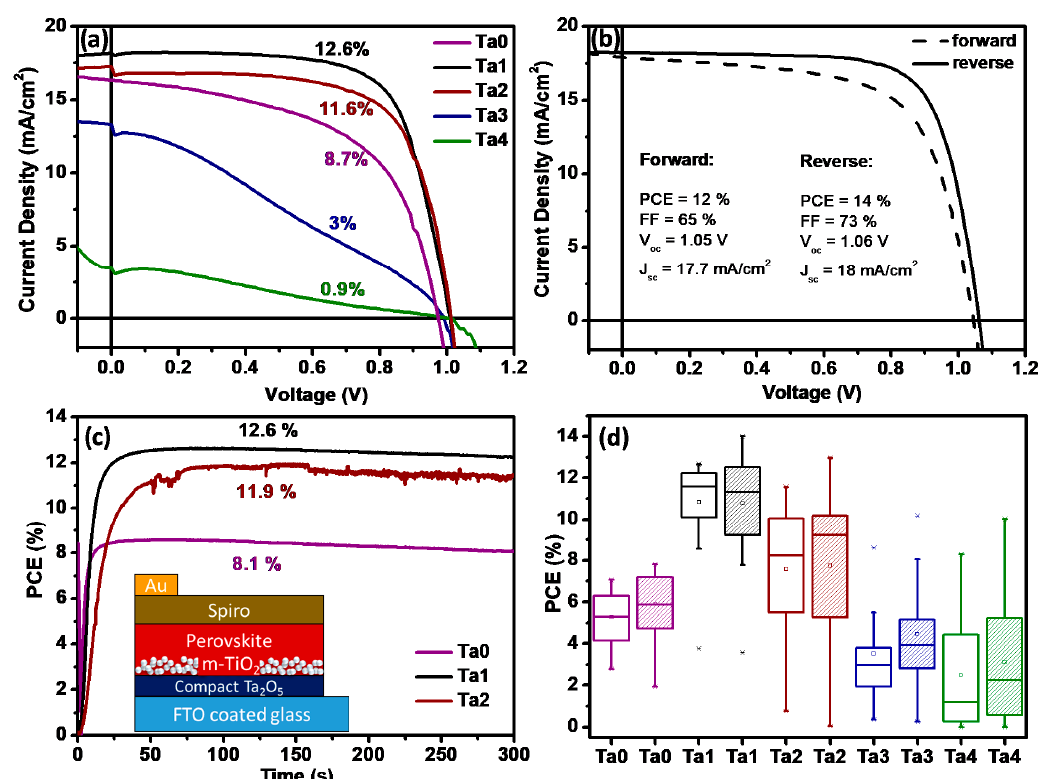
Figure 5. Comparison of ( a ) J–V curves (forward sweep). ( b ) Champion cell of perovskite solar cells employing Ta 2 O 5 as ETL (Ta1). ( c ) Steady-state power conversion efficiency at maximum power point (0.78 V applied bias); inset shows a schematic of the layered stack used for the devices. ( d ) Box plots displaying the distribution of device efficiencies fabricated on Ta0, Ta1, Ta2, Ta3 and Ta4 films (forward and reverse sweep). Table 2. Photovoltaic parameters of PSCs, using amorphous Ta 2 O 5 layers of different thicknesses (Ta0–Ta4) as their ETLs.